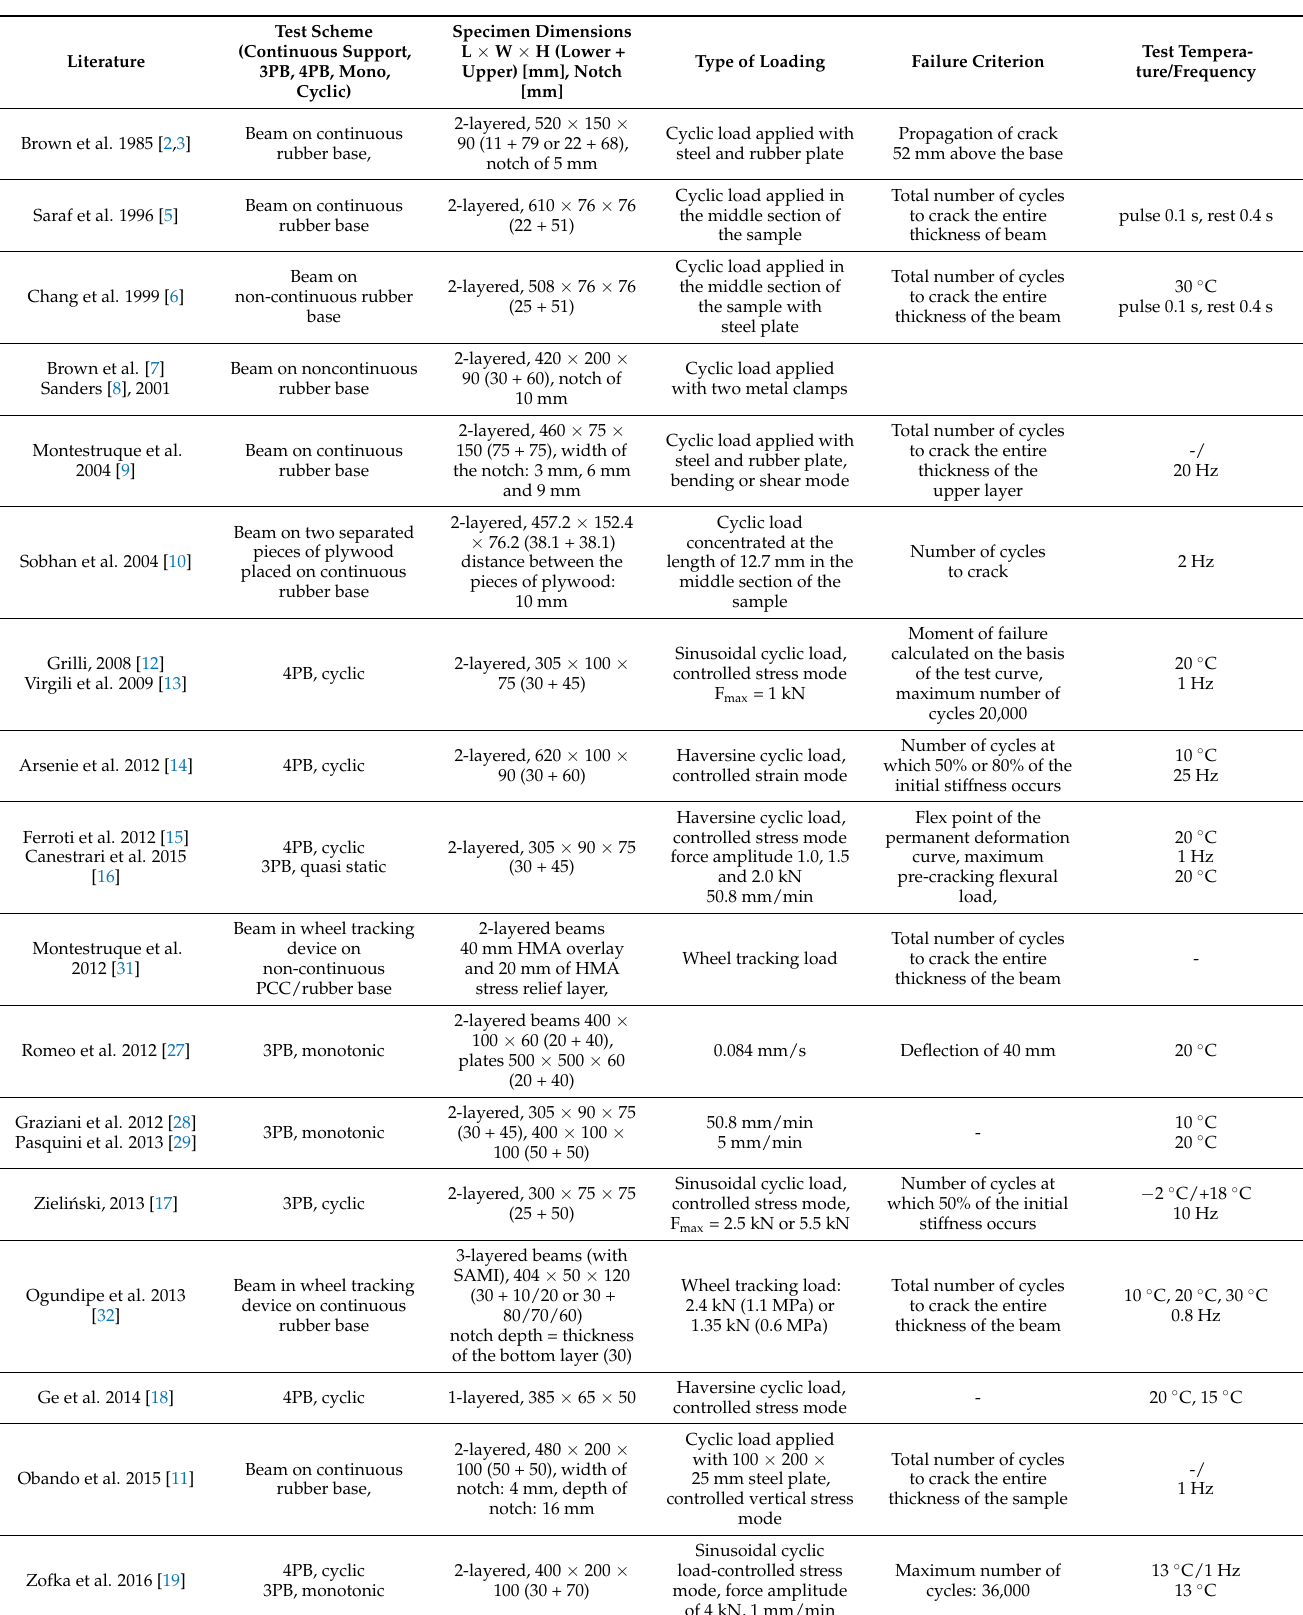
Table 1. Summary of fatigue test conditions based on literature